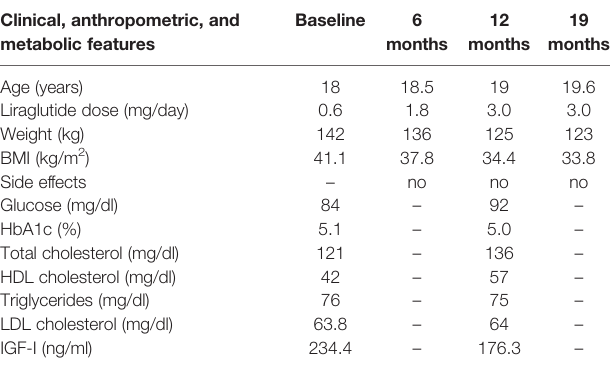
TABLE 1 | Clinical, anthropometric, and metabolic features at baseline and during liraglutide treatment. Clinical, anthropometric, and metabolic features